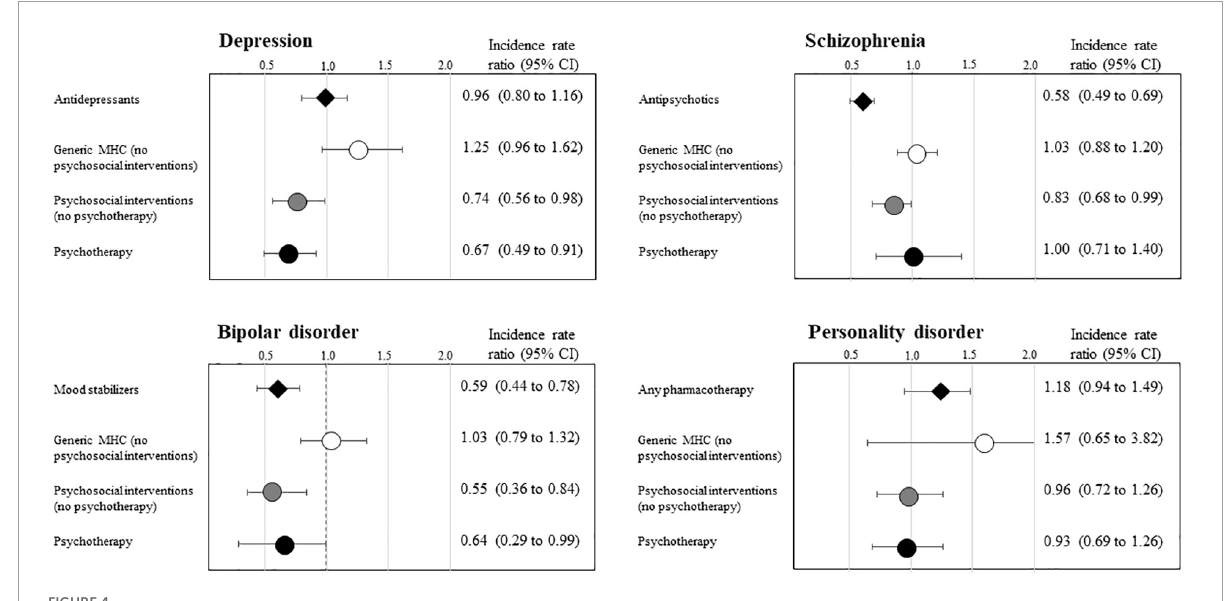
FIGURE4 Self-controlled case-referent series estimates of the incidence rate ratio of relapse episodes associated with categories of mental care, according with the main diagnosis of depression, schizophrenia, bipolar disorder, and personality disorder. QUADIM-MAP project, Italy, 2013–2018. Self-controlled case-referent series incidence rate ratio, and 95% confidence interval, estimated with Poisson regression contrasting within-patient incidence of relapse onset observed during mental care coverage and no coverage person-time. Relapse was emergency hospital admissions in a psychiatric ward. Estimates were obtained through the design shown in Supplementary Figure 1 ; please see the extensive footnote of Supplementary Figure 1 for details about the design. Time-windows with width of 180 and 90 days respectively prior and following the relapse onset were removed for mitigating the effect of incorrect allocate person-time of MHC